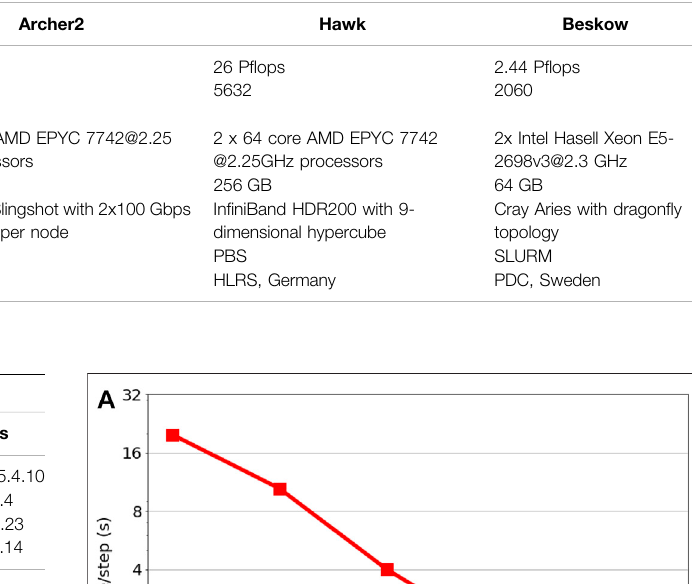
TABLE 2 | HPC systems overview.